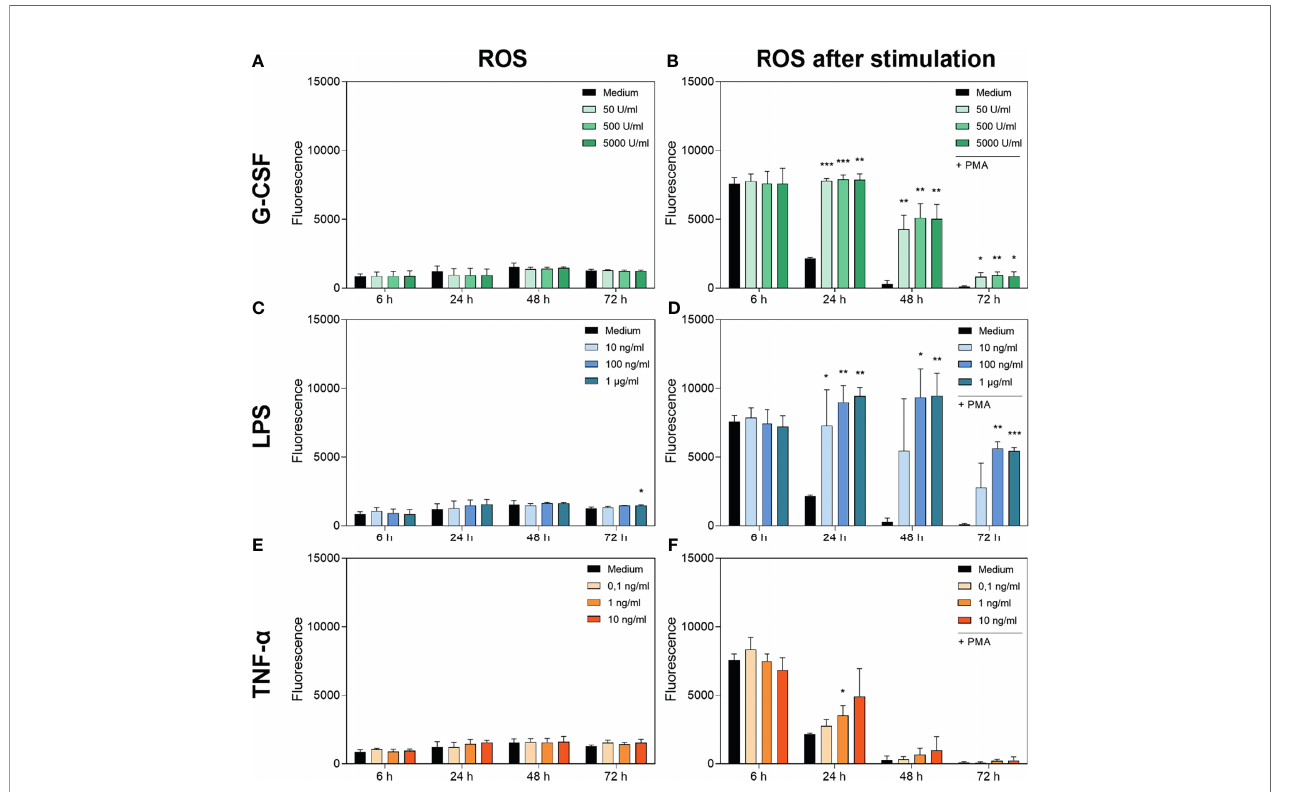
FIGURE 3 | Measurement of ROS accumulation (left panel) and PMA-induced ROS production (right panel) in neutrophils cultured with G-CSF (A, B) , LPS (C, D) or TNF- a (E, F) over 72 h by fl uorometric measurement of ROS compared to an untreated control (Medium). Fluorometric measurement was conducted with samples stimulated with 20 nM PMA after 6 h, 24 h, 48 h and 72 h. The displayed fl uorescence is proportional to ROS produced. Values represent means ± SD of n = 3. Differences between the untreated control group and one treated group each were calculated individually using student ’ s t-test. Levels of signi fi cance were set at < 0.05 (*), < 0.01 (**), < 0.001